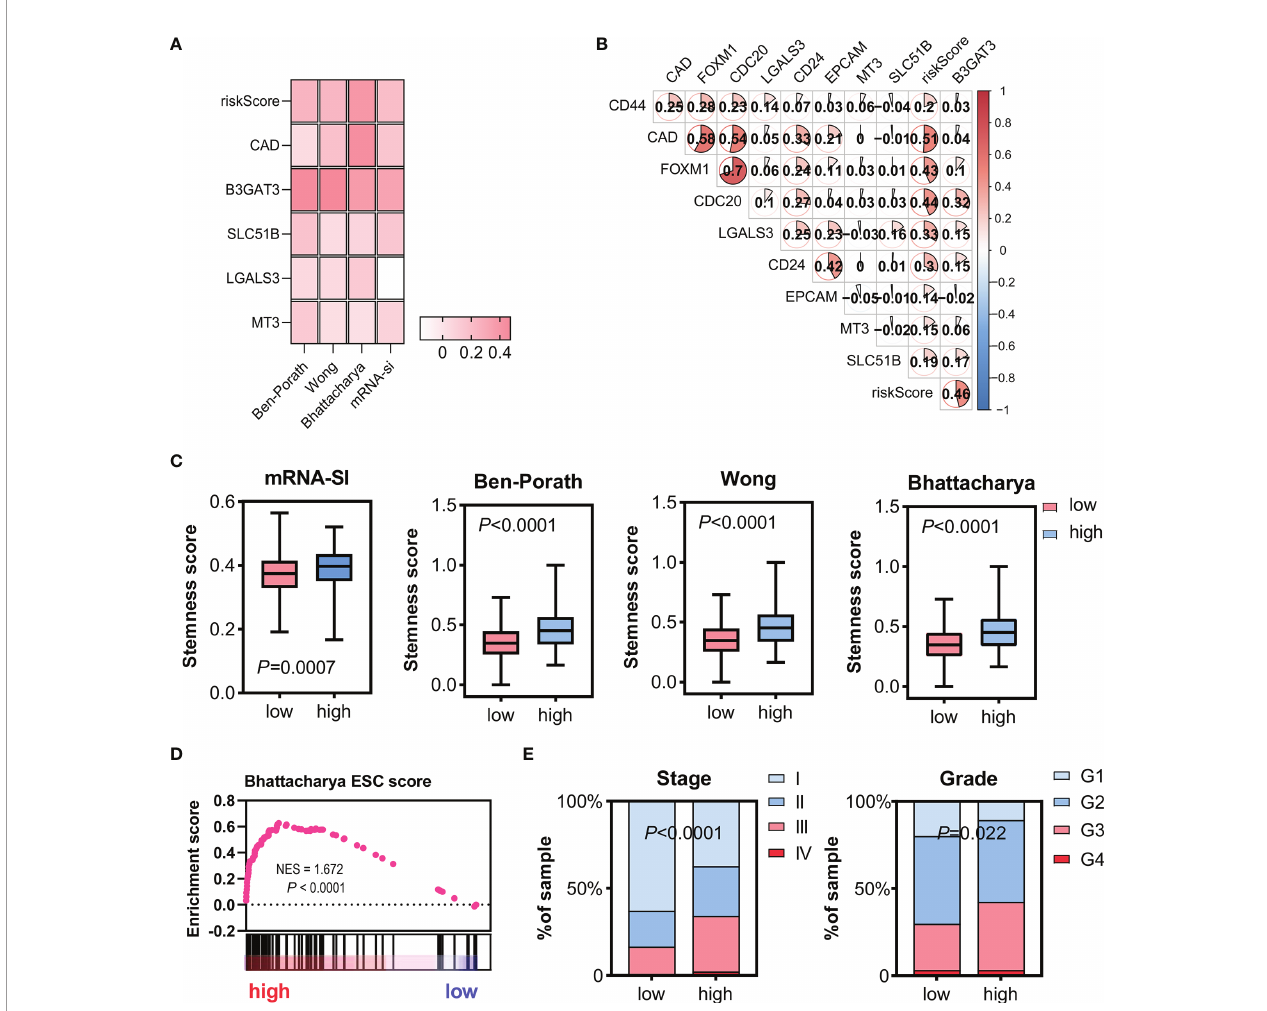
FIGURE 3 | Relationship between gene expression pro fi les and HCC stemness using HCC bulk data from TCGA-LIHC. (A) Heatmap of Spearman ’ s correlation results of the gene expression pro fi les and four distinct stemness indices (Ben-Porath signature, Wong signature, Bhattacharya signature, and mRNA-si). A darker color represents a stronger correlation. (B) Correlation between the CSC markers, CD24, CD44, CD20, FOXM1, and EpCAM, and the gene expression pro fi les. (C) Different scores of the four distinct stemness indices between the low- and high-risk groups. (D) The transcriptome pro fi les of high-risk HCC patients were signi fi cantly enriched with stemness markers. (E) Among the high-risk patients, the frequency of higher stages and grades was more signi fi cantly elevated. Tumor stages and grades were color-coded as shown in the legend. NES, normalized enrichment score; CSC, cancer stem